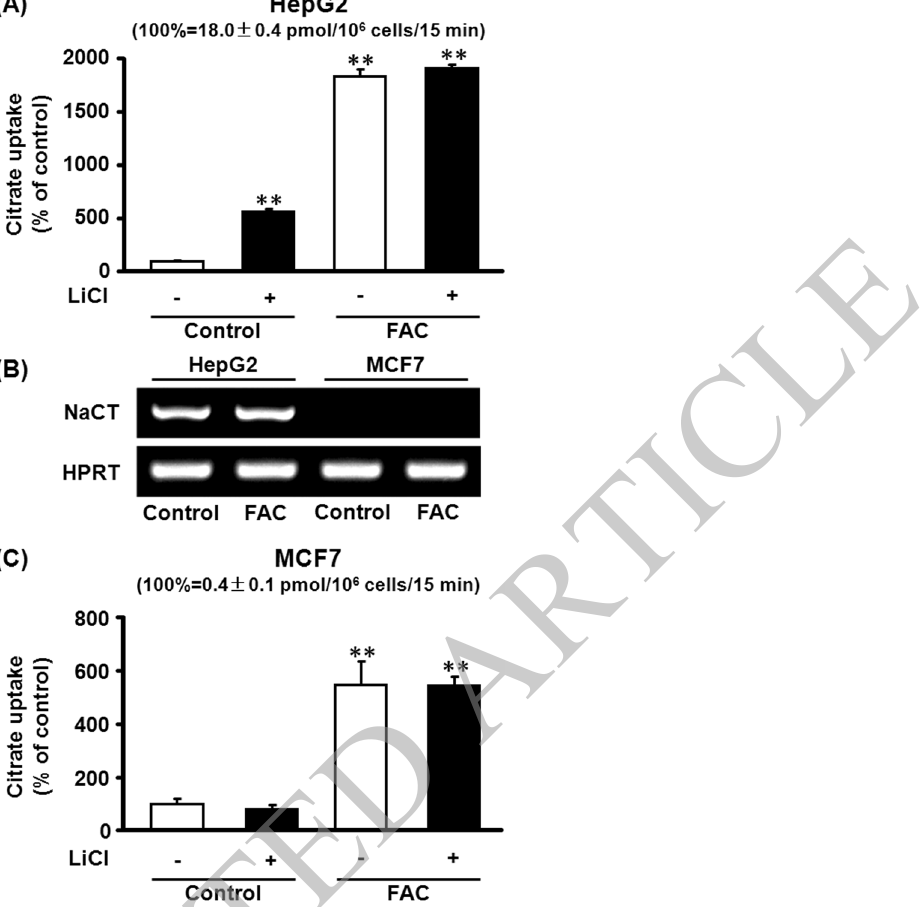
Figure 2. Non-involvement of NaCT in citrate uptake stimulated by FAC pretreatment. ( A ) HepG2 cells were cultured in the absence or presence of FAC (250 μ g/ml) for two passages. The cells were then seeded for uptake measurements and cultured in the absence or presence of FAC; confluent cells were used for [ 14 C]-citrate (3.5 μ M) uptake (NaCl buffer, pH 7.5; 15 min incubation) in the absence or presence of 10 mM LiCl. ( B ) RT- PCR for expression of NaCT mRNA in control and FAC-treated HepG2 and MCF7 cells. The PCR products from both cell lines were run on the same gel to detect NaCT or HPRT (The images of the entire gels are given in Supplementary Fig. S7). ( C ) MCF7 cells were cultured in the absence or presence of FAC (250 μ g/ml) for two passages. The cells were then seeded for uptake measurements and cultured in the absence or presence of FAC; confluent cells were used for [ 14 C]-citrate (3.5 μ M) uptake (NaCl buffer, pH 7.5; 15 min incubation) in the absence or presence of 10 mM LiCl. ** p <